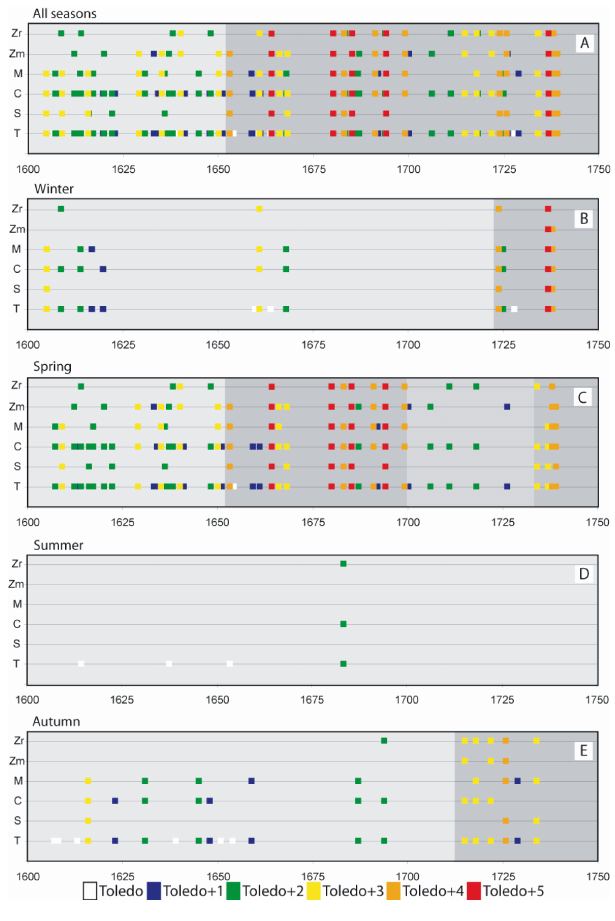
Fig. 5. Annual and seasonal simultaneous rogations in Toledo (T) and any other site, Seville (S), Catalonia (C), Murcia (M), Zamora (Zm), Zaragoza (Zr), for the period